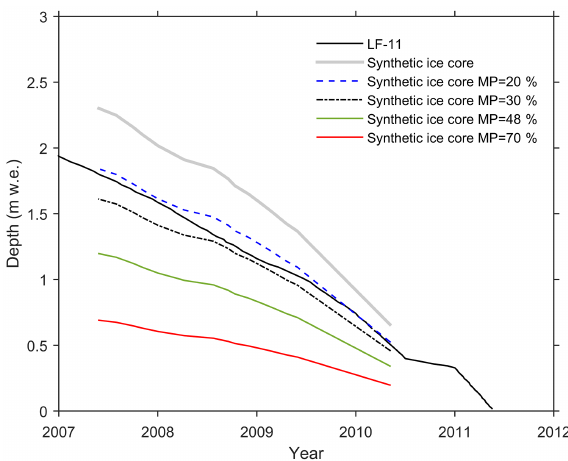
Figure 16. Depth–time scales for the LF-11 and LF-syn ice cores during 2007–2011 (black and grey lines, respectively). Blue dashed, black-dot-dashed, green and red lines represent the synthetic core depth–time scale considering a MP of 20, 30, 48 and 70%, respec-